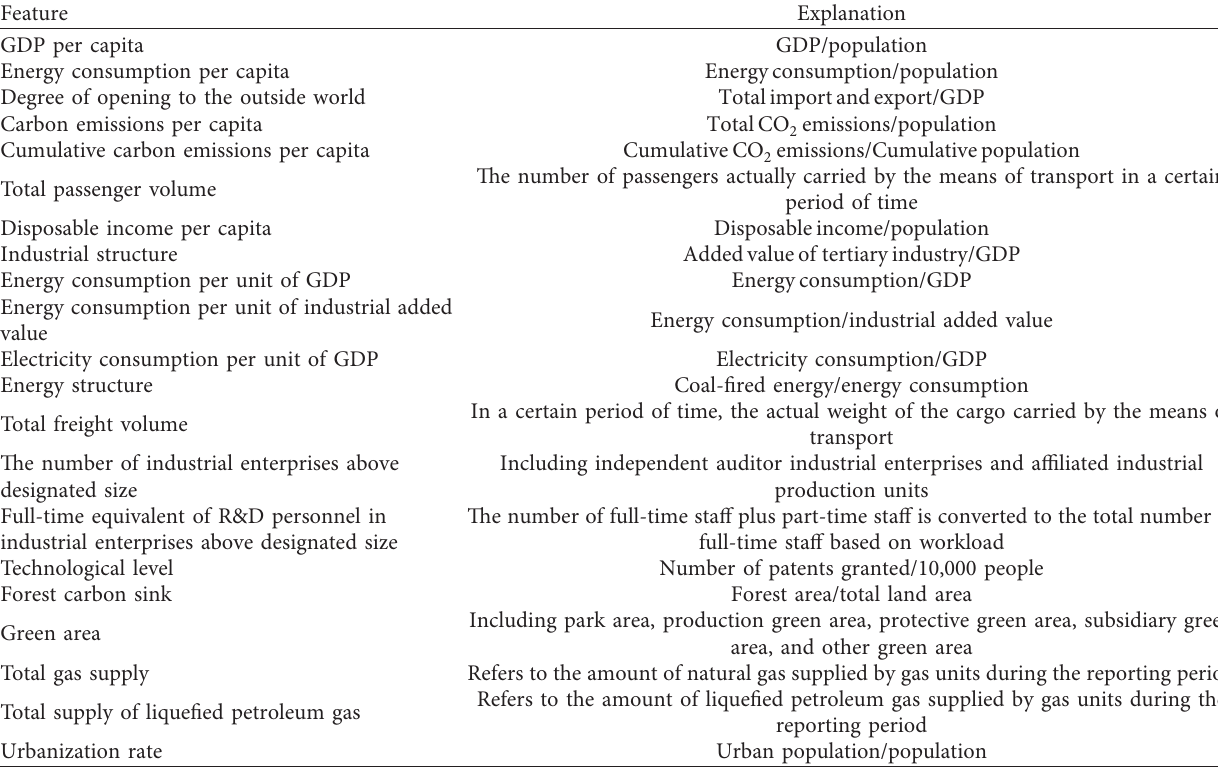
Table 2: Specific explanation of